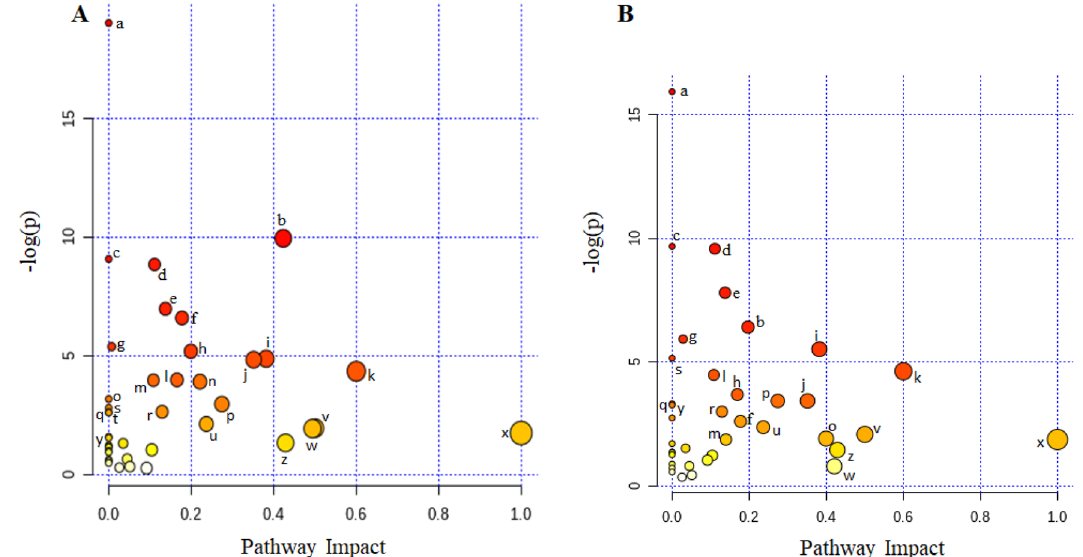
Figure 4. Pathway analysis of ruminal fluid ( A ) and feces ( B ) polar metabolites of Nelore steers. This analysis was undertaken using MetaboAnalyst 4.0 software according to the Bos taurus KEGG pathway database. Darker colored, larger areas of the bubbles represent more significant metabolite changes in the corresponding pathway. The letters indicate the pathways (see Table